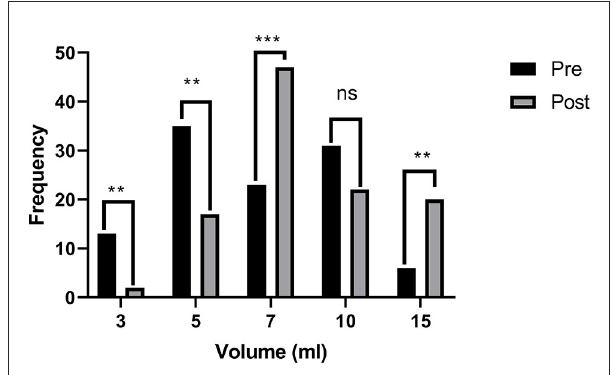
FIGURE7 Respondent’s answers to the volume of type II spoons are shown in Chart One, pre-, and post-intervention. ** means very